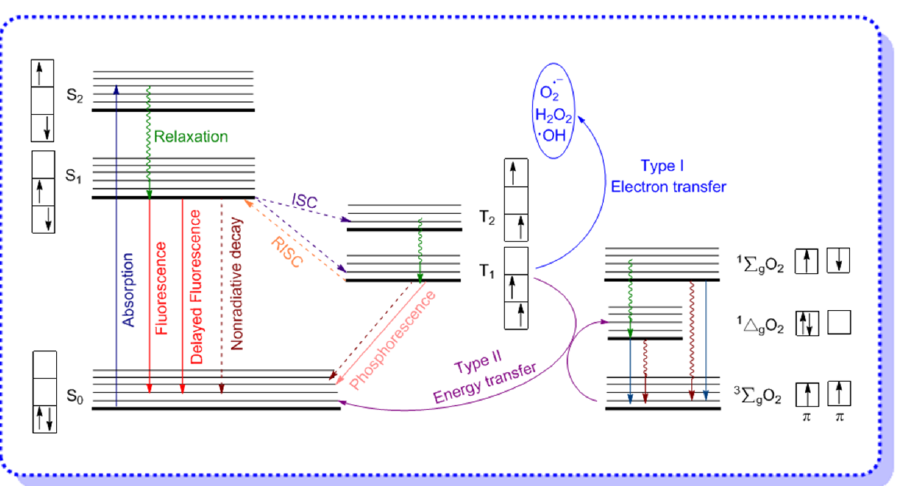
Figure 2. Photophysical and photochemical processes illustrated by a modified Jablonski energy diagram: The aggre- gated aggregation-induced emission photosensitizer (AIE – PS) in singlet excited (S 1 ) state may undergo intersystem diagram: The aggregated aggregation-induced emission photosensitizer (AIE–PS) in singlet excited crossing (ISC) to an excited triplet state (T 1 ) and then generate reactive oxygen species (ROS). Adapted and modified with (S 1 ) state may undergo intersystem crossing (ISC) to an excited triplet state (T 1 ) and then generate permission from references 5 (copyright 2017, Elsevier), 6 (copyright 2016, Royal Society of Chemistry), and 16 (copy- reactive oxygen species (ROS). Adapted and modified with permission from references 5 (copyright right 2020, Wiley-VCH). 2017, Elsevier), 6 (copyright 2016, Royal Society of Chemistry), and 16 (copyright 2020,